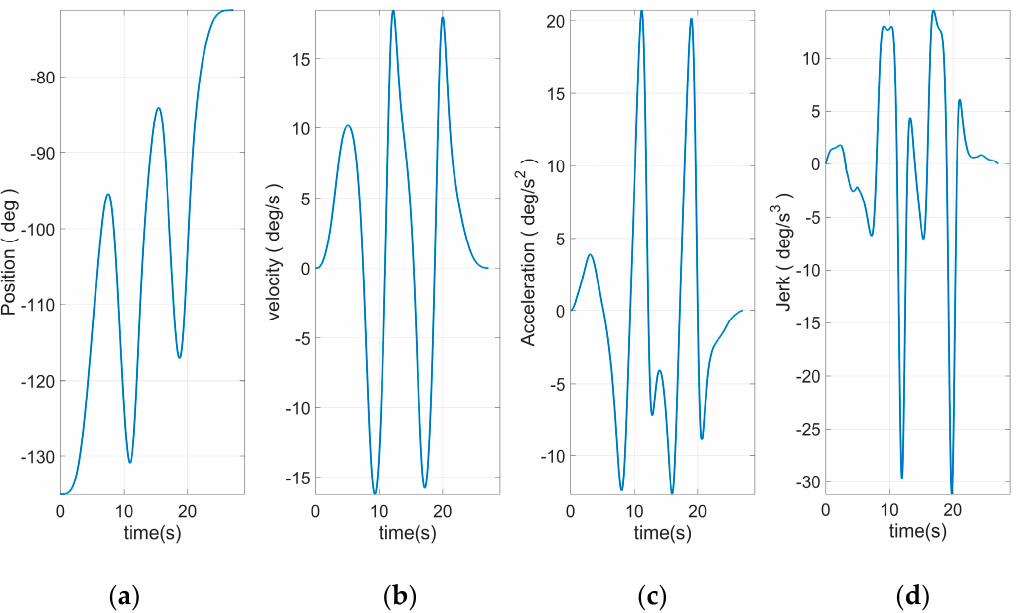
Figure 14. ( a ) Displacement of axis IV over time. ( b ) Velocity of axis IV over time. ( c ) Acceleration of